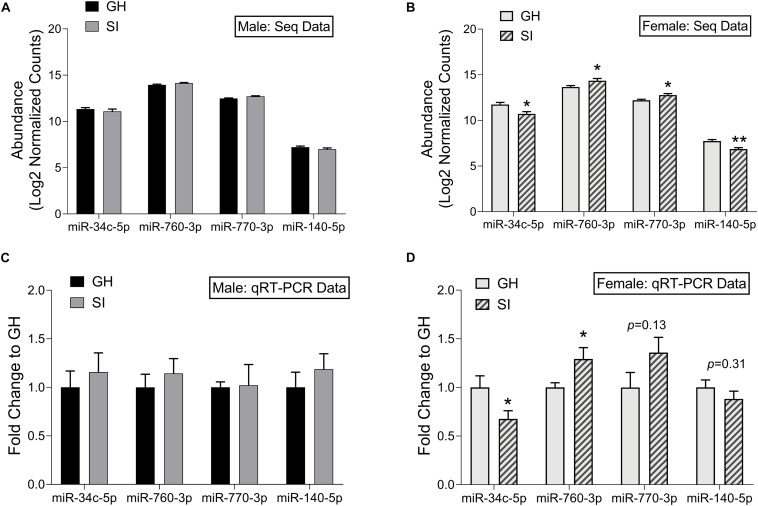
Validation of small RNA sequencing results using qRT-PCR. Log2 normalized counts (abundance) of miRNAs in SI and GH conditions as measured by small RNA sequencing; males (A) and females (B). n = 5 rats/group. Fold induction (to GH condition) of qRT-PCR results in the adBNST for levels of miRNAs shown in (A,B); Males (C) and females (D). n = 6–9 rats/group. ∗p < 0.05, ∗∗p < 0.01, p = X (trend for significance), compared to GH condition for each miRNA. GH, group housed; SI, socially isolated.